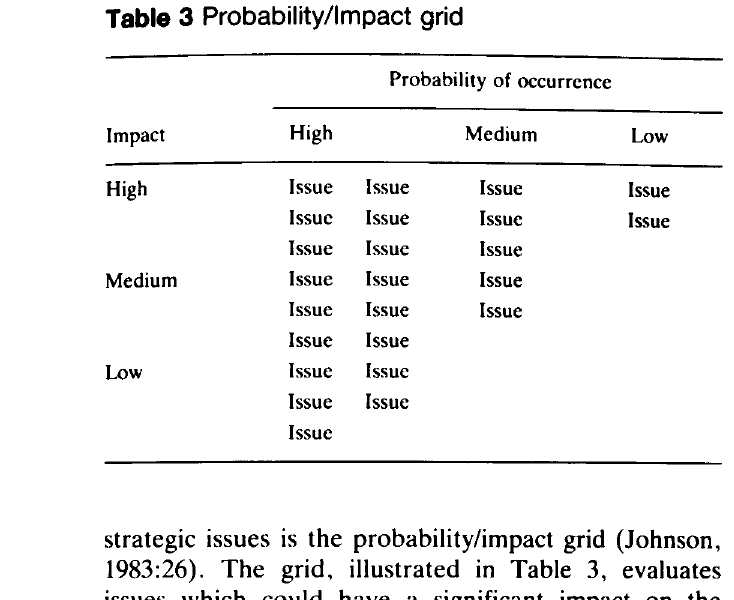
Table 3 Probability/Impact